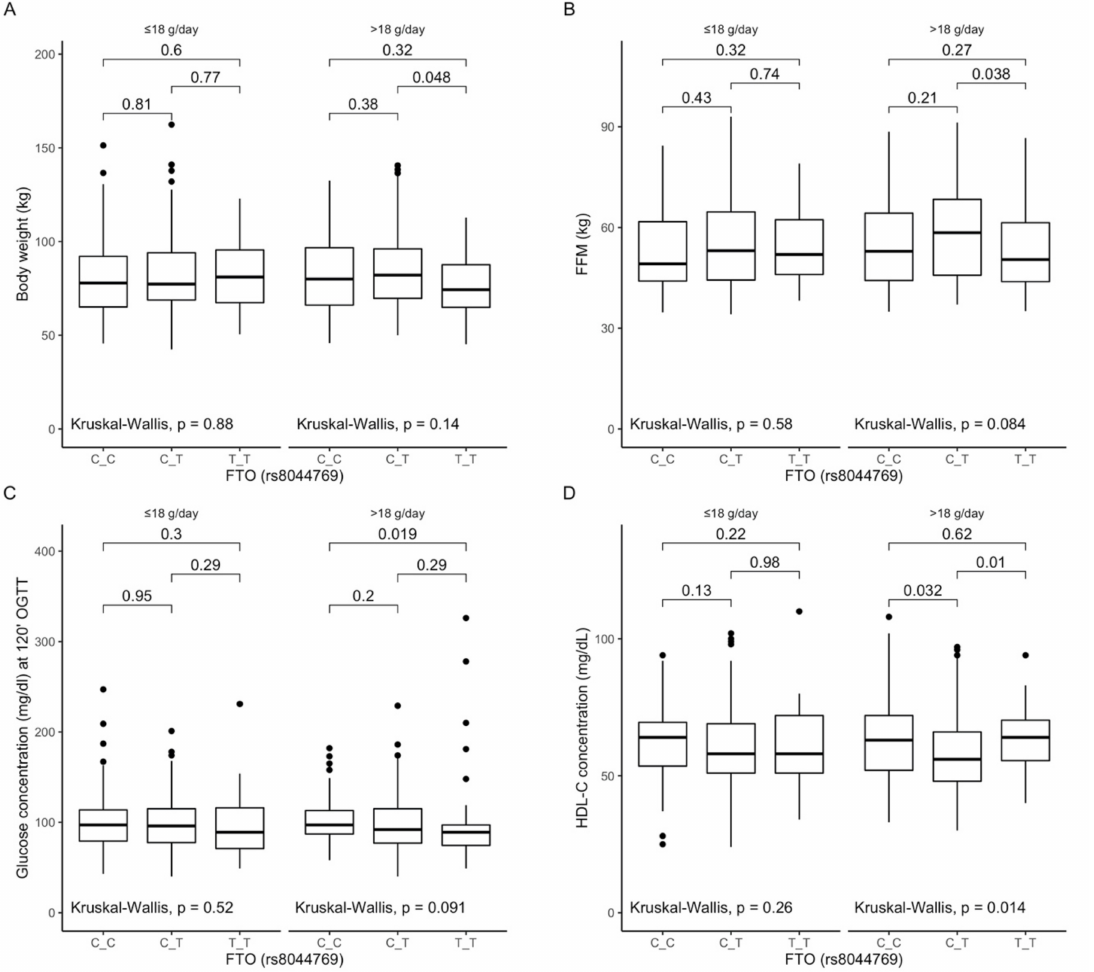
Figure 4. Association of the FTO rs8044769 genotypes with ( A ) Body weight (kg); ( B ) Fat-free mass content (FFM) (kg); ( C ) Glucose concentration (mg/dL) at 120 min of OGTT; ( D ) HDL-C concentration (mg/dL) by dietary fiber intake strata: ≤ 18 g/day and >18